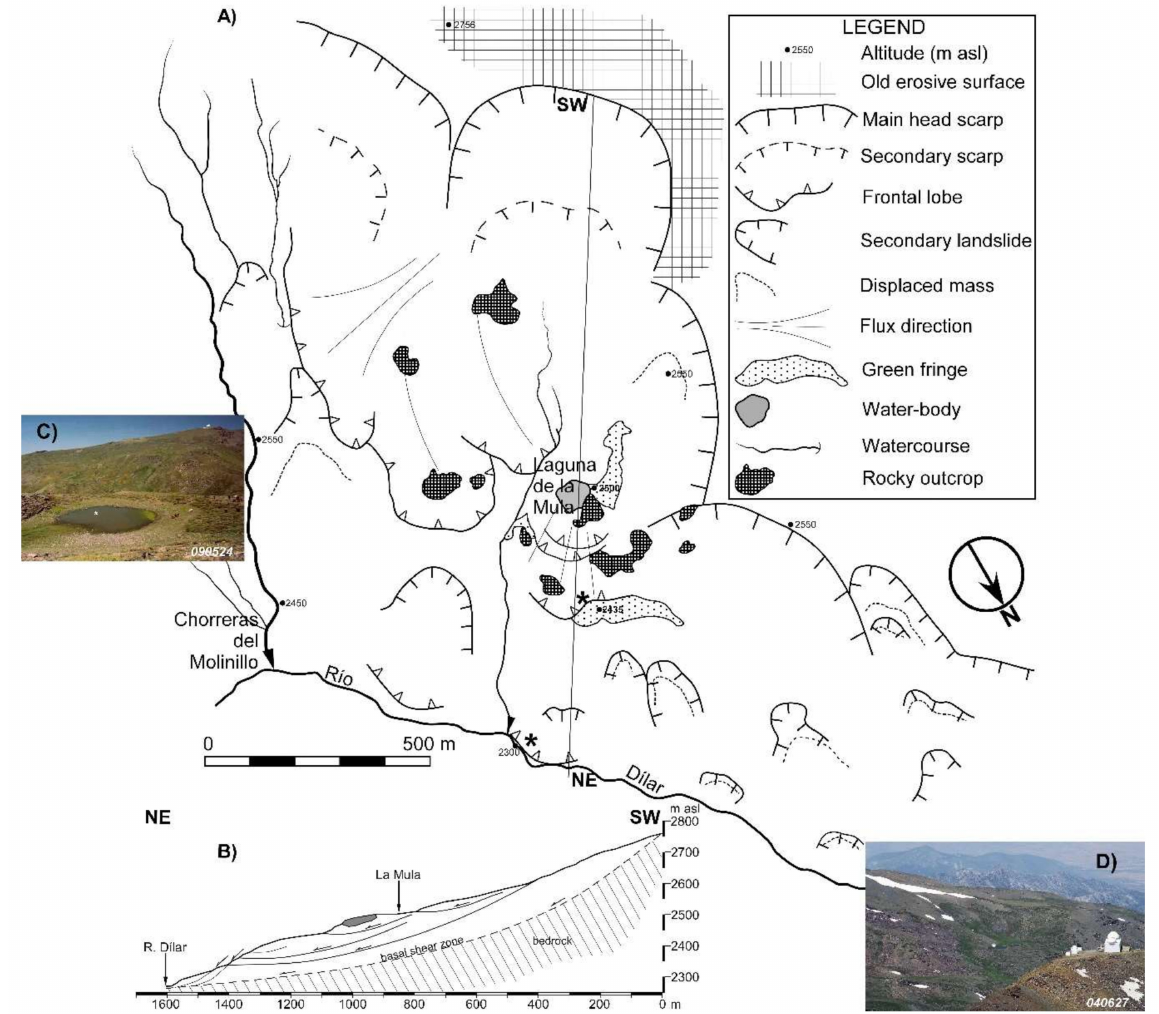
Figure 12. ( A ) Landslide mapping of Laguna de la Mula. Black asterisks indicate two fronts of this landslide, at two different levels: the higher overlaps a meadow, and the lower displaces the D í lar riverbed. See also Figure 6C. ( B ) Cross-section of a landslide. ( C , D ) Images obtained, respectively, in periods of drought and thaw. White asterisks indicate the position of the water